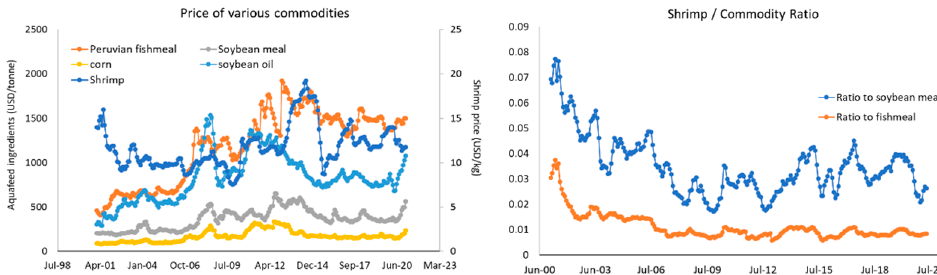
Figure 5. Price of various raw feed ingredients and shrimp (shell-on, headless, 26 to 30 counts per pound) as a food commodity (left); and shrimp to commodity ratio for two key raw ingredients, fishmeal, and soybean meal (right). Source: adapted from IndexMundi data [125].